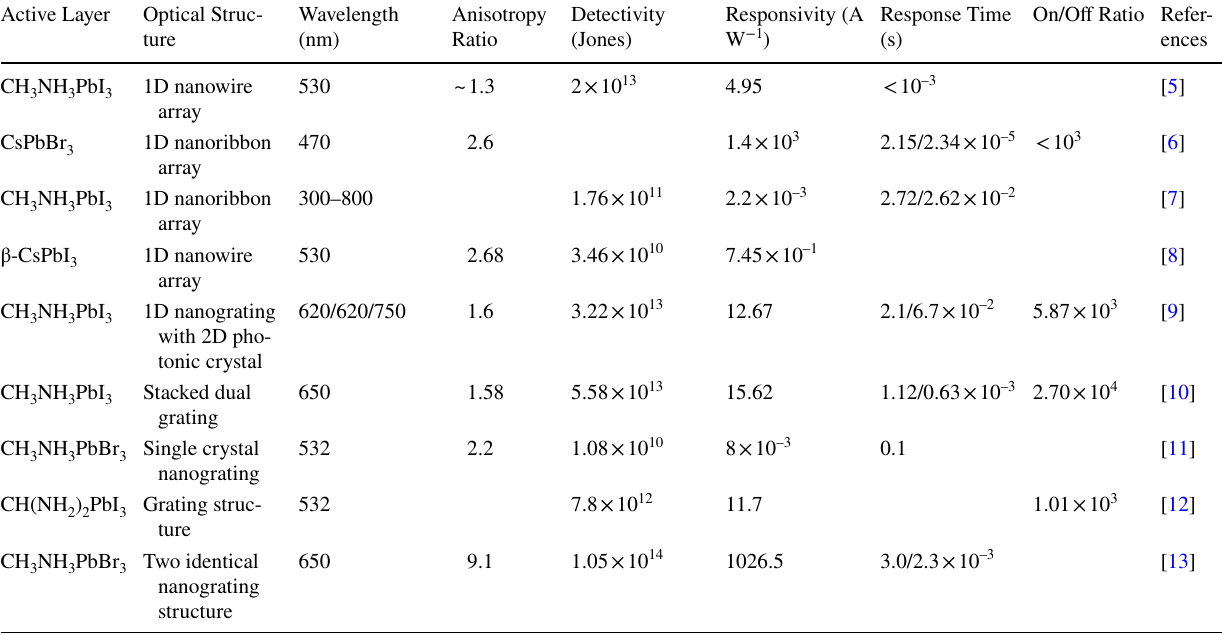
Table 1 Performance for optical structure-based LP-PPDs Active Layer Optical Struc- ture